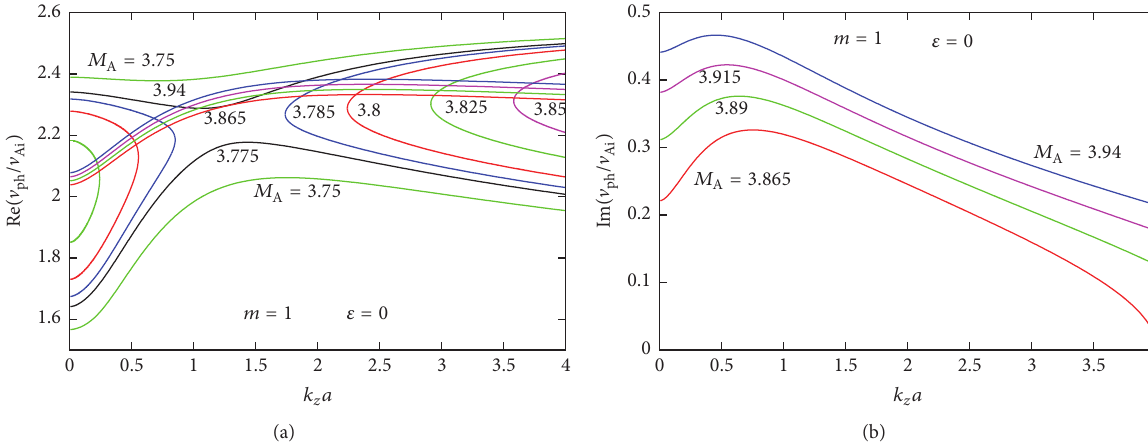
Figure 2: (a) Dispersion curves of stable and unstable kink ( 𝑚 = 1 ) MHD mode propagating in a moving untwisted magnetic flux tube of compressible plasma (modeling jet #11) at 𝜂 = 0.896 and 𝑏 = 2.44 . Unstable dispersion curves located above the middle of the plot have been calculated for four values of the Alfv´en Mach number 𝑀 A = 3.865 , 3.89 , 3.915 , and 3.94 . (b) The normalized growth rates of the unstable mode for the same values of 𝑀 A . Red curves in both plots correspond to the onset of KH instability.